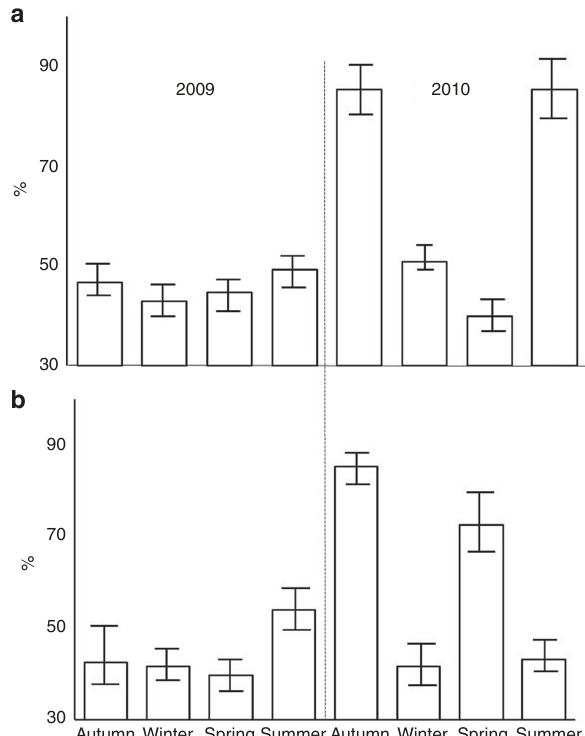
Fig. 2 Empty pteropod shells. Empty pteropod shells expressed as seasonal % of the total pteropods collected for each year (2009 – 2010) at P2 ( a ) and P3 ( b ). Error bars indicate 1 standard deviation (replicates n = 4 – 6)